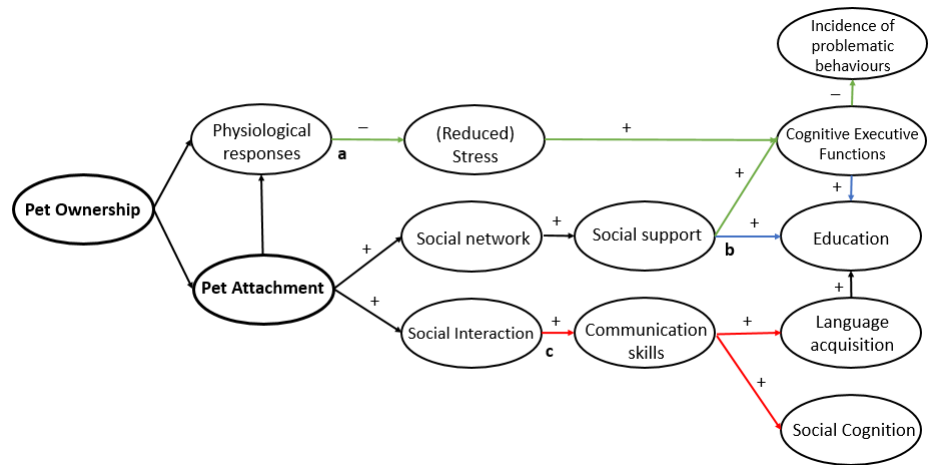
Figure 5. Hypothesized links for the impact of pet ownership and attachment on cognitive and educational outcomes, that postulates ( a ) Executive Functions are indirectly supported by stress reduction and increased social support, and therefore a reduced incidence of problematic behaviours follows (green) and ( b ) improved academic outcomes may result due to education being positively affected by improved executive functions and increased social support (blue) and ( c ) social cognition and language acquisition are enhanced by communication and social interaction with pets (red).